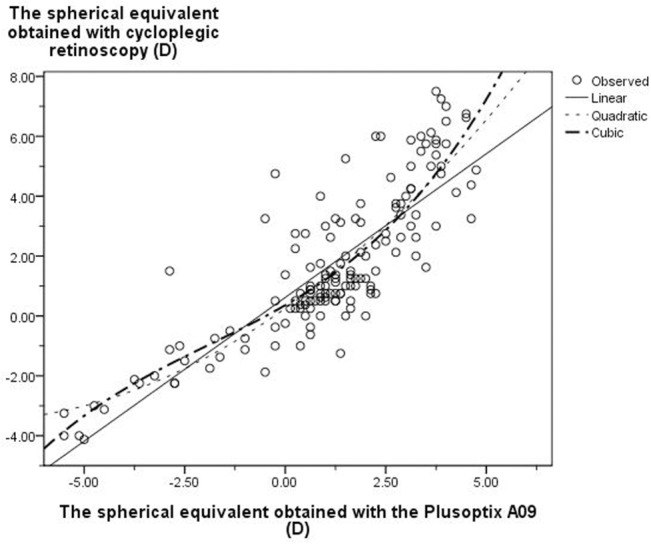
The relationship between the results of the Plusoptix A09 and cycloplegic retinoscopy (three types of custom regression models including linear, quadratic and cubic regression).